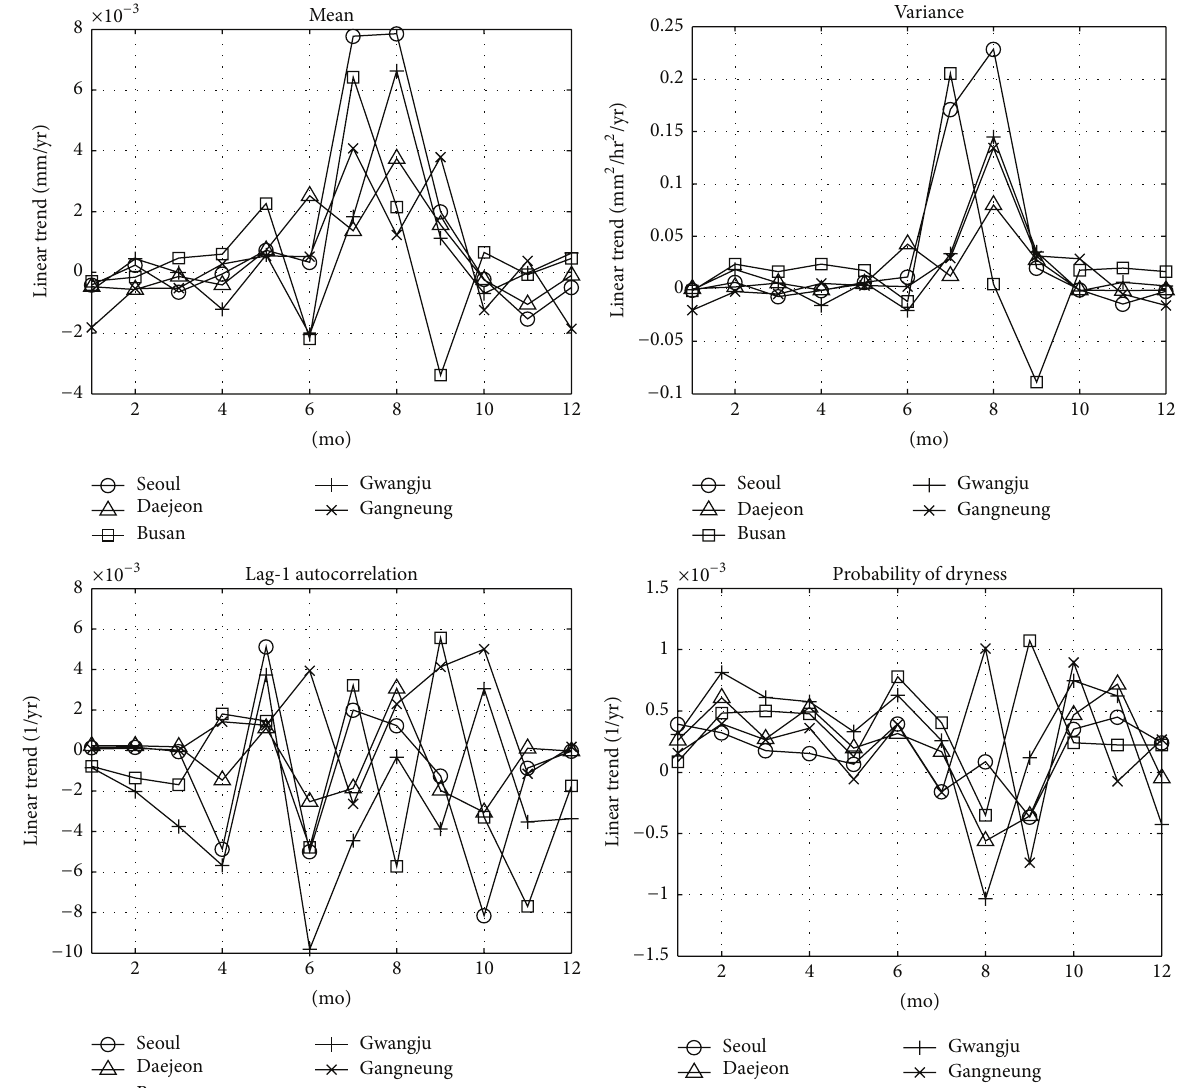
Figure 5: Seasonal variation of linear trend of 20-yearly 1-hour precipitation mean, variance, lag-1 autocorrelation, and probability of dryness of Korean